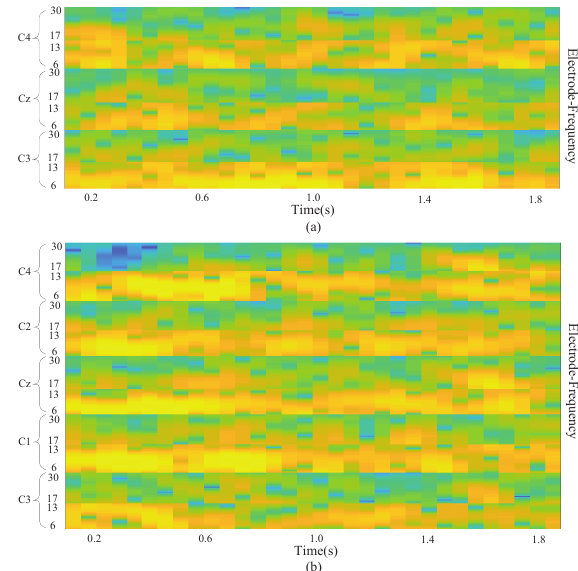
Figure 2. Input image with 3 electrodes and 5 electrodes. ( a ) is the input image with 3 electrodes; ( b ) is the input image with 5